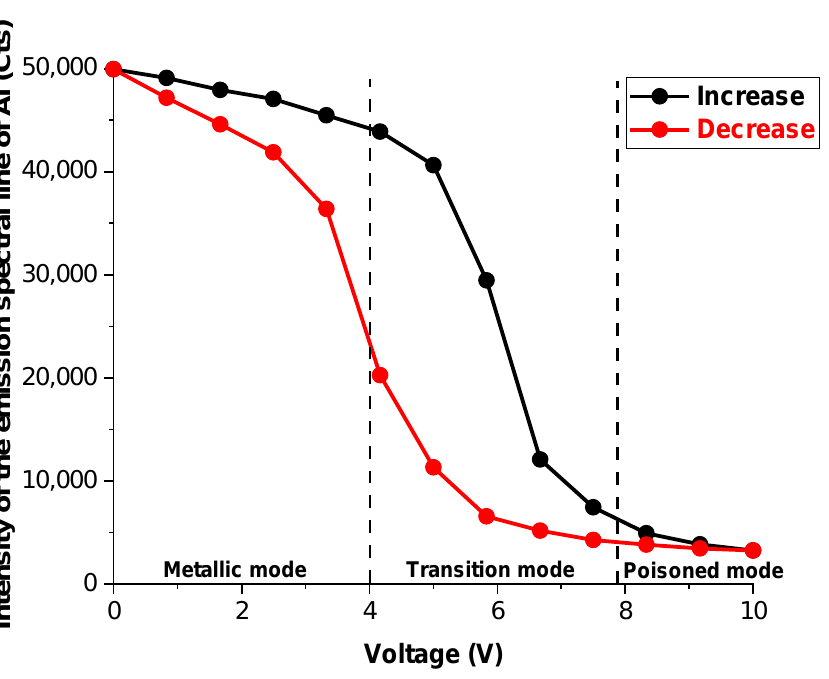
Figure 3. Hysteresis curve of the aluminum targets obtained at 1.84 W/cm 2 by monitoring the intensity of the emission spectral line of Al as a function of the voltage value used by the PEM to inject the oxygen flow.